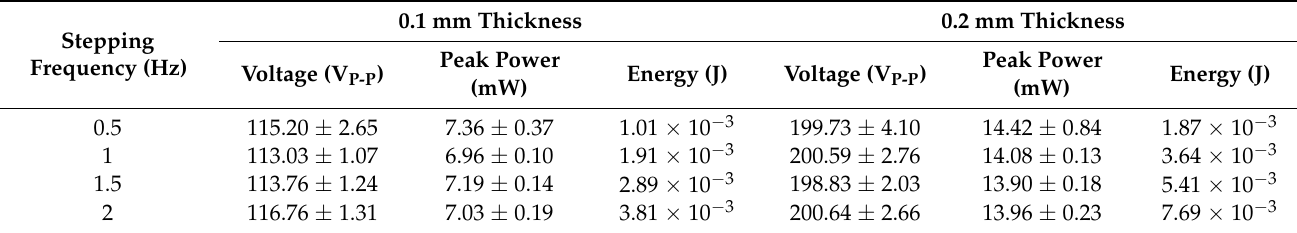
Table 1. Output voltage, peak power, and cumulative energy across an optimal load for the TEHFT with 0.1 mm and 0.2 mm thick PTFE film at different pressing frequencies.